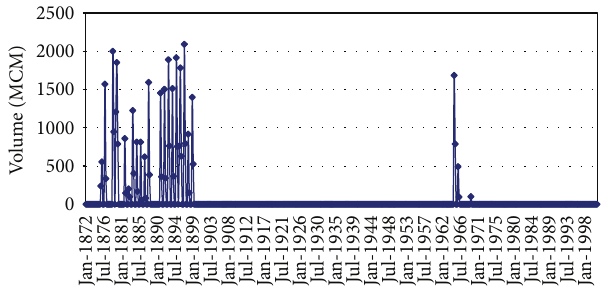
Figure 13: Overflow time series for TD configuration B.